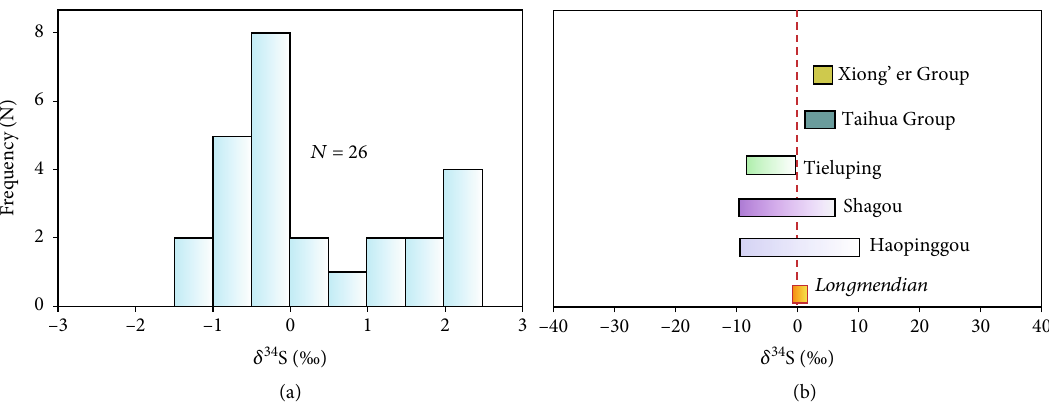
Figure 11: Sul fi de S isotope compositions from Longmendian and other Ag-Pb-Zn deposits. Data source: the Tieluping, Shagou, and Haopinggou deposits [34]; the Xiong ’ er Group and Taihua Group